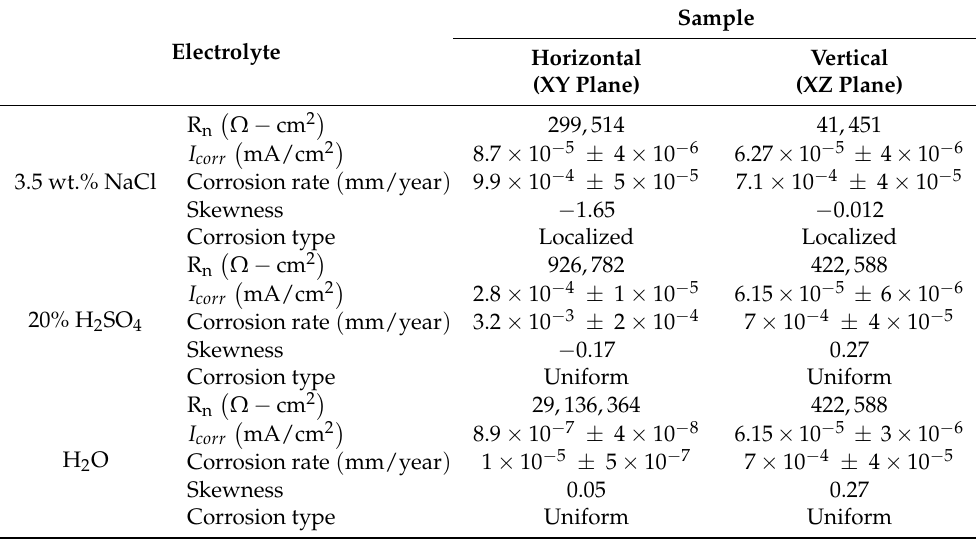
Table 5. Electrochemical noise (EN) characteristics of the SLMed 316L SS tested in the three elec- trolytes (3.5 wt.% NaCl, 20% H 2 SO 4 , and H 2 O ) .